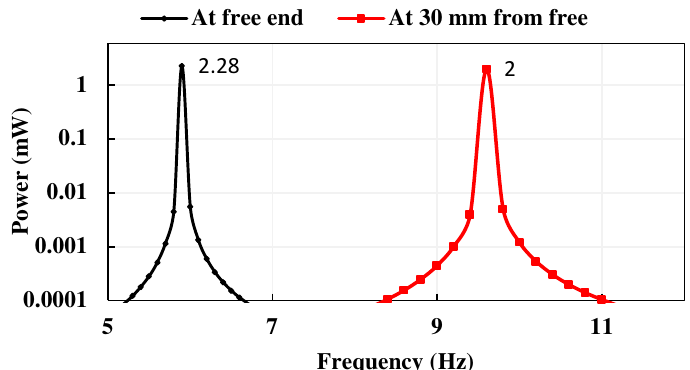
Figure 16. The frequency response of the output power of the piezoelectric harvester at two positions